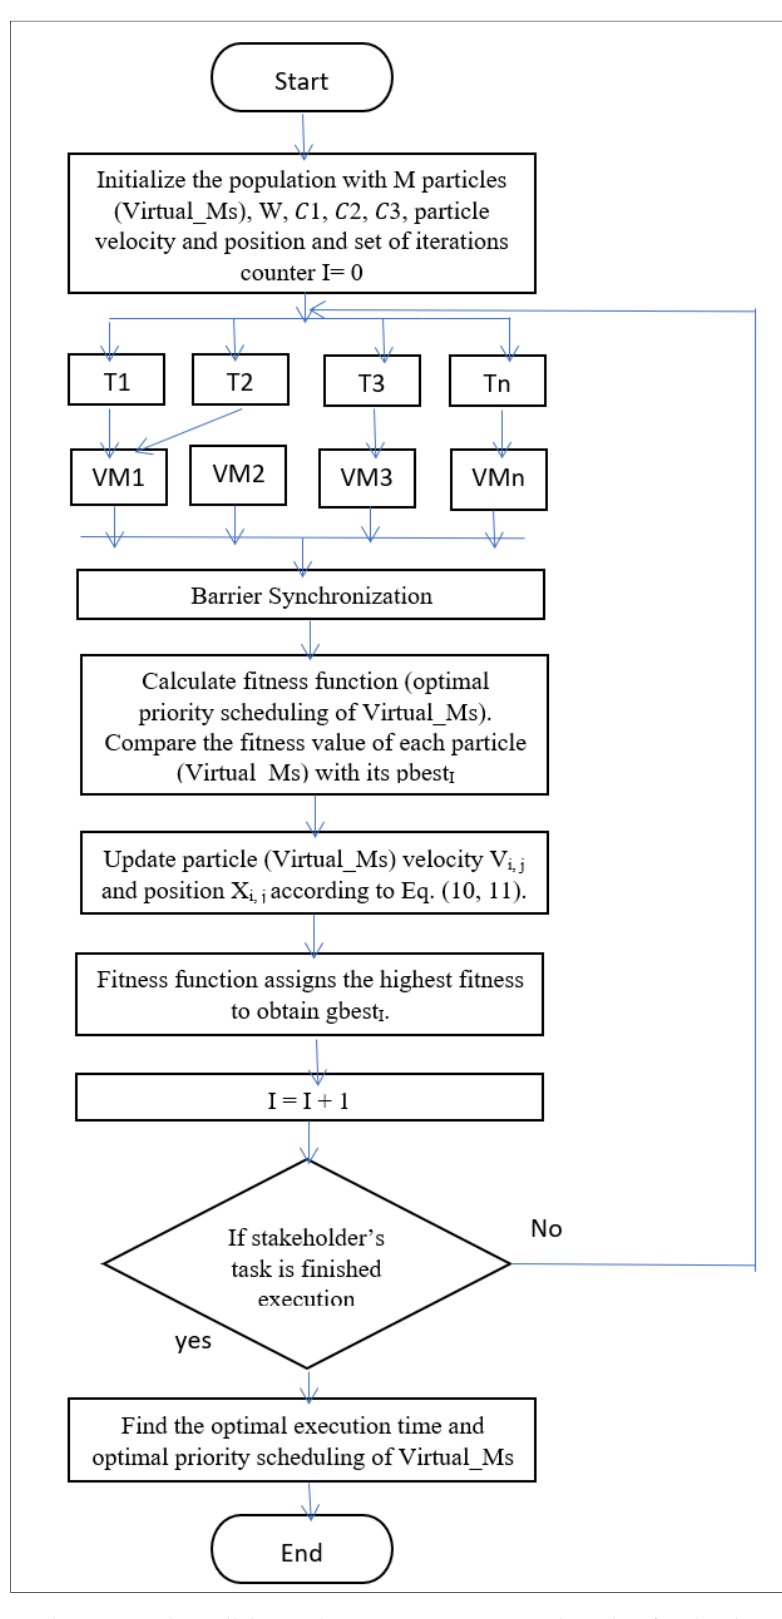
Figure 3. The proposed parallel particle swarm optimisation algorithm for cloud computing.